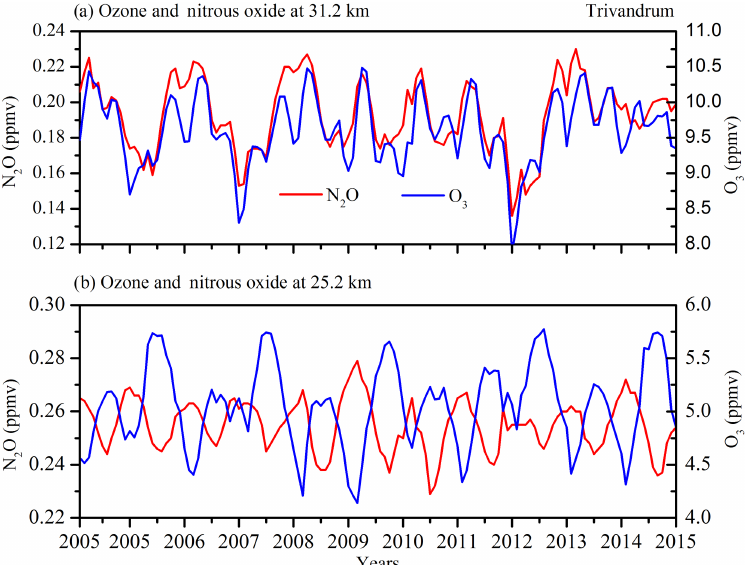
Figure 9. Monthly averaged N 2 O (red) and O 3 ratios at (a) 31.2km and (b) 25.2km over Trivandrum obtained from AMLS